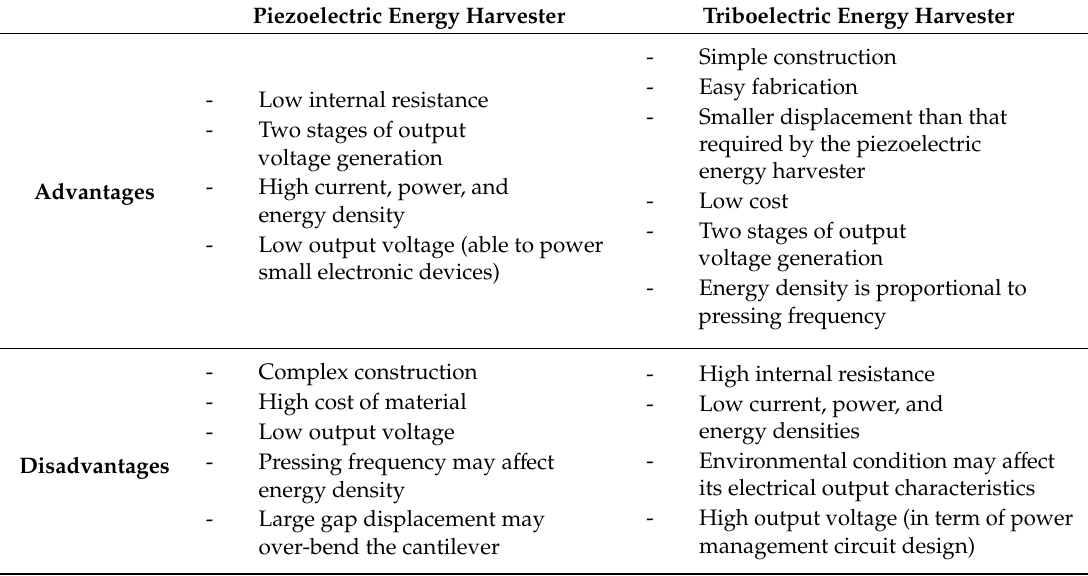
Table 5. Advantages and disadvantages of PEH and